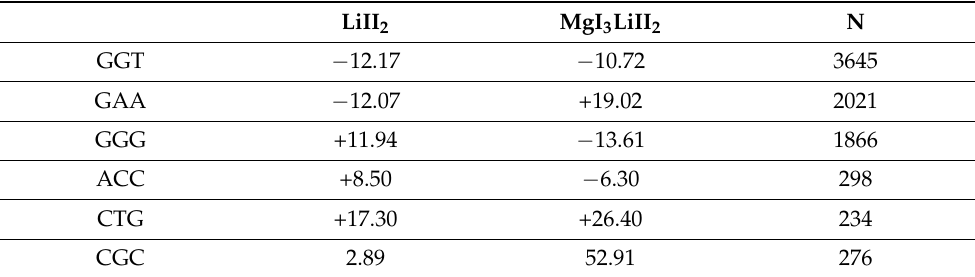
Table 5. Energy interactions (kcal/mol) of nucleotide triplets with active centers of the FS-1 drug and the frequency of epigenetic modifications in nucleotide triplets Staphylococcus aureus under the action of the FS-1 drug